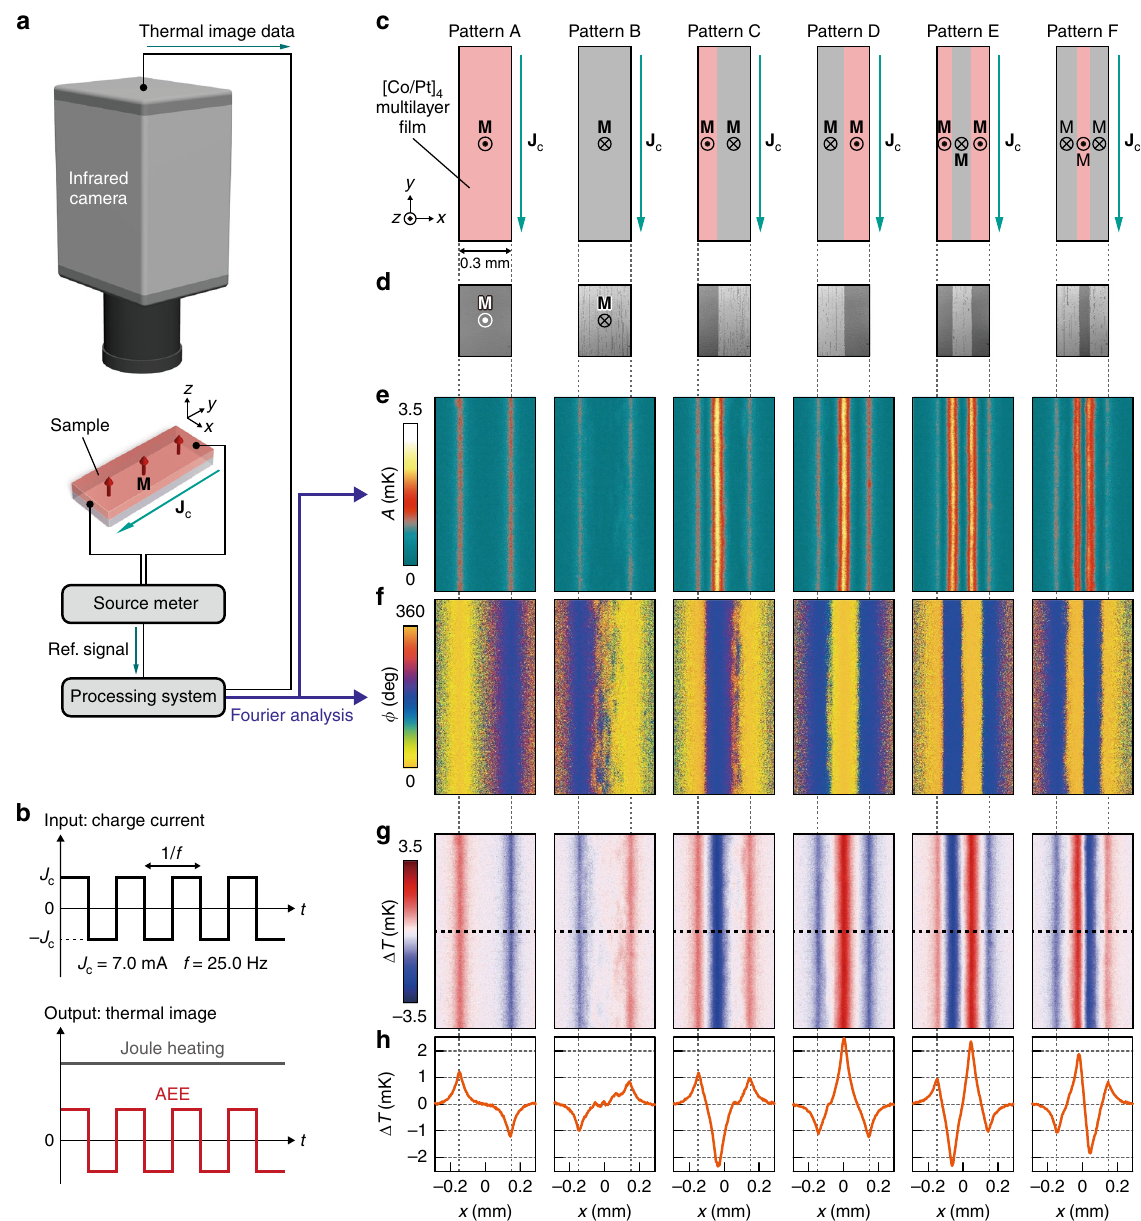
Fig. 3 Demonstration of magneto-optical painting of heat current. a Lock-in thermography method for the AEE measurements. The temperature modulation synchronized with the charge current is extracted by Fourier analysis. b Time charts of the input charge current and output temperature changes induced by the AEE and Joule heating. In the AEE measurements, the square-wave-modulated alternating charge current with the amplitude J = 7.0 mA, frequency f = 25.0 Hz, and zero offset was applied to the samples. c Magnetic domain patterns A – F designed via the AO-HDS on the [Co/Pt] c strips. d Magneto-optical images corresponding to the patterns A – F. e , f Lock-in amplitude A ( e ) and phase ϕ ( f ) images for the [Co/Pt] 4 strips with the patterns A – F. g Δ T ( = A cos ϕ ) images for the [Co/Pt] 4 strips. Each image consists of 192 × 370 pixels. h Surface Δ T pro fi les along the x direction. The pro fi les were obtained by averaging 50 x -directional raw pro fi les along the y direction; the center of the averaged area is marked with black dotted lines in g